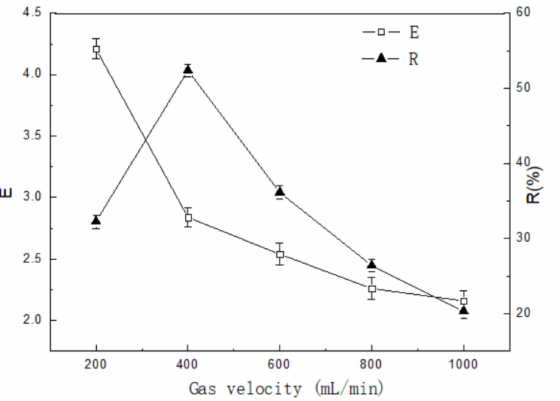
Figure 3. Effects of separated gas velocity on enrichment ratio and